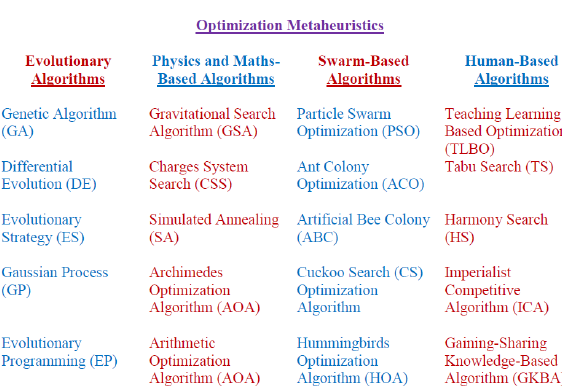
Fig. 1. One Classification of Optimization Metaheuristics with